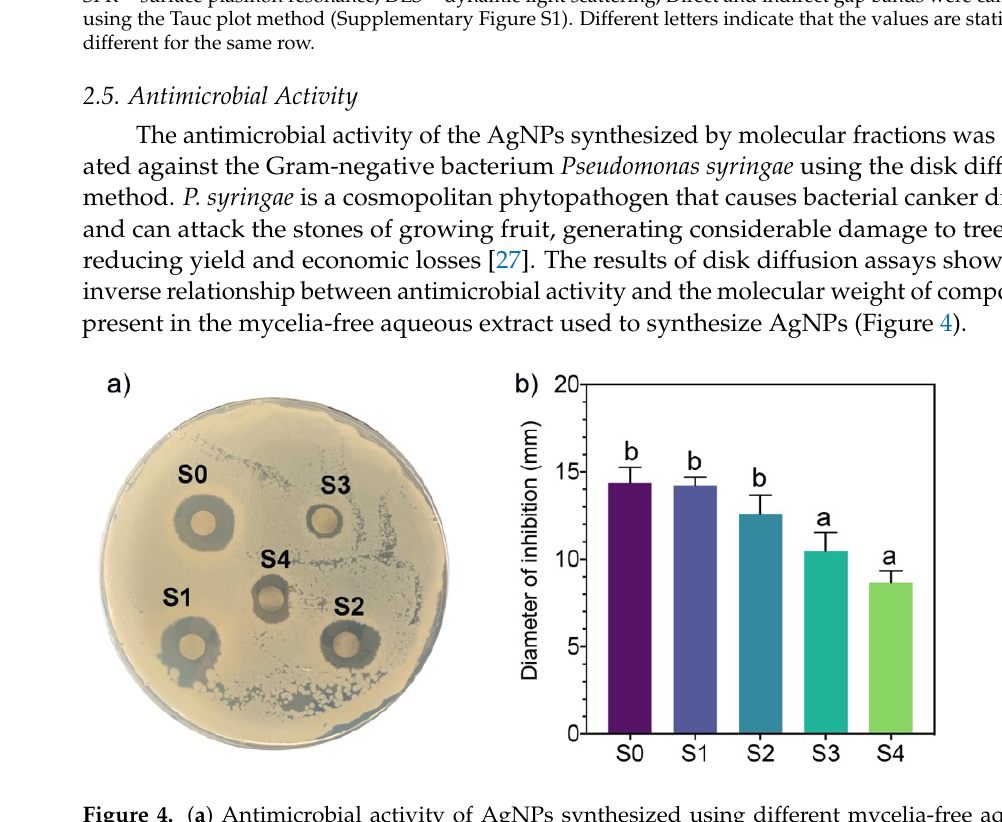
Figure 5. Antimicrobial mechanisms of AgNPs.